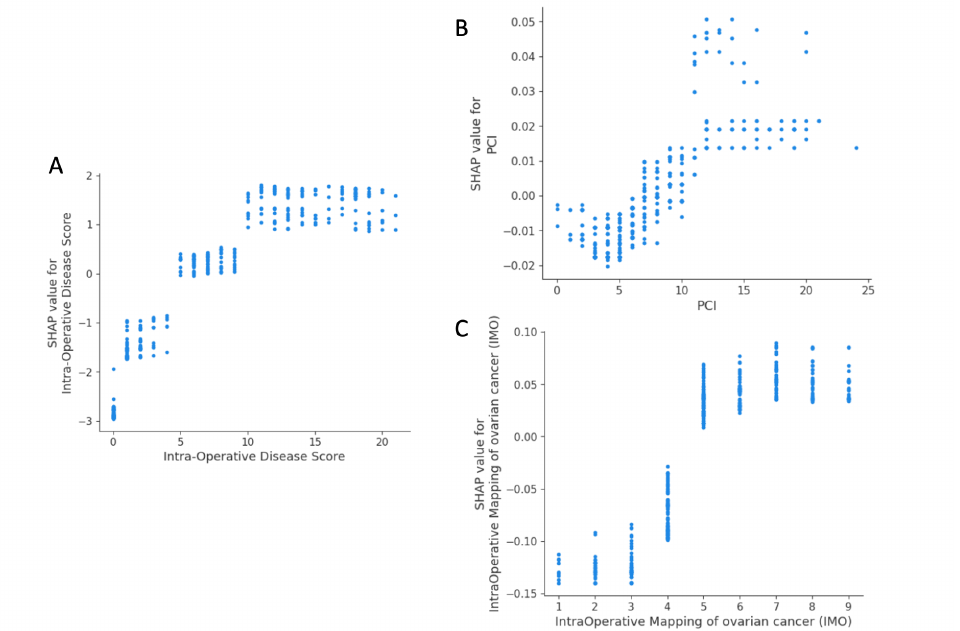
Figure 4. Examples of SHAP value dependence plots for global explainability features describing EOC pattern dissemination. ( A ) Novel intra-operative disease score; ( B ) PCI; ( C ) IMO. PCI, Peritoneal Carcinomatosis Index; IMO, Intra-operative Mapping for Ovarian Cancer.